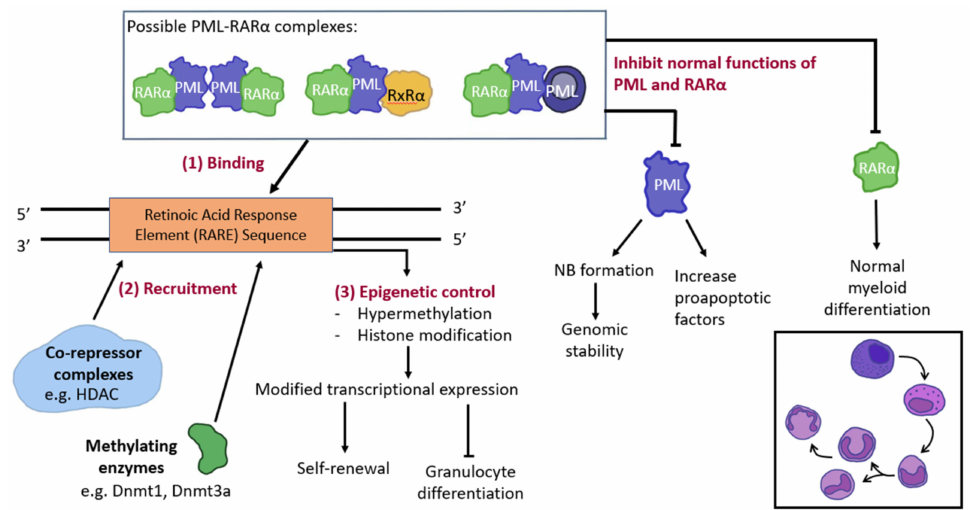
Figure 1. Pathogenesis of acute promyelocytic leukaemia (APL). The formation of various PML::RARA complexes due to the translocation between chromosomes 15 and 17 t(15;17)(q24;q21), which bind to the retinoic acid response element (RARE). The binding of PML::RARA to RARE leads to the recruitment of co-repressors and methylating enzymes (e.g., DNMT1 (DNA (cytosine- 5)-methyltransferase 1) and DNMT3A), resulting in epigenetic silencing, inhibition of granulocyte differentiation, accumulation of abnormal promyelocytes and increasing self-renewal. Formation of PML::RARA complexes also inhibits normal functions of PML and RARA such that PML is unable to cause cell apoptosis and tumour suppression via nuclear body (NB) formation. RAR α ability to allow localization with RxR α resulting in transcriptional